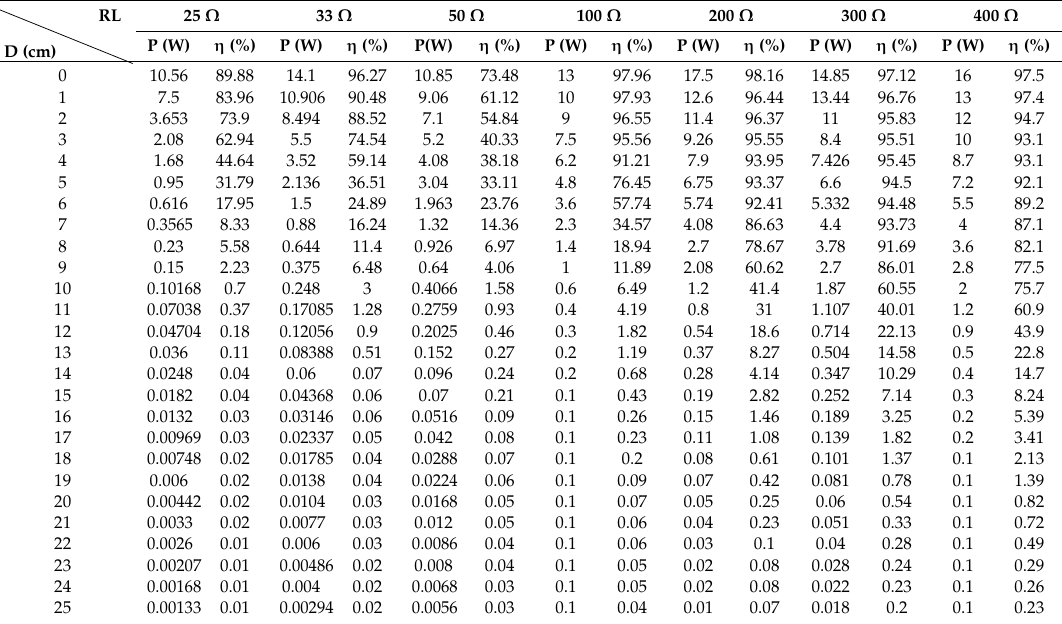
Table 4. The parameters for MRC based-loads at second topology at RL.